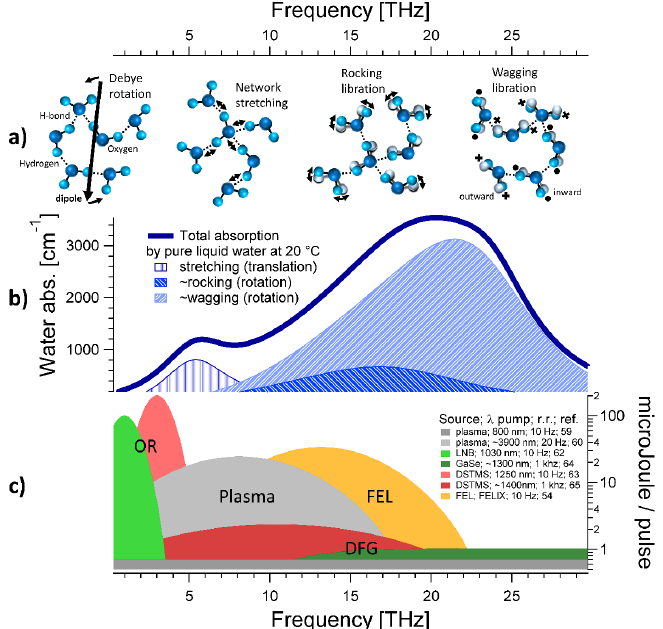
Figure 1. ( a ) Cartoons of the di ff erent modes of liquid water in the TetraHertz (THz) range. Below 1 THz, the dielectric response is dominated by the Debye-like reorientation of the collective dipole of H-bonded water molecules [18–22]. Intermolecular translations or “network stretching” modes are centered at ca. 6 THz, while librational modes are found between ~10 and ~20 THz [24–26]. ( b ) Equilibrium absorption coe ffi cient of pure water at T = 20 ◦ C [1–4]. A minimal fit reveals at least three bands that can be associated to the intermolecular modes sketched in panel ( a ). ( c ) Summary of the most intense THz sources reported to date. Gray: plasma generation; green: emission from inorganic crystals by non-linear optical methods; red: emission from organic materials; orange: frequency region of a pump-probe experiment operating at a free electron laser. The laser wavelength, repetition rate (r.r.), and the reference number is indicated. See text for further